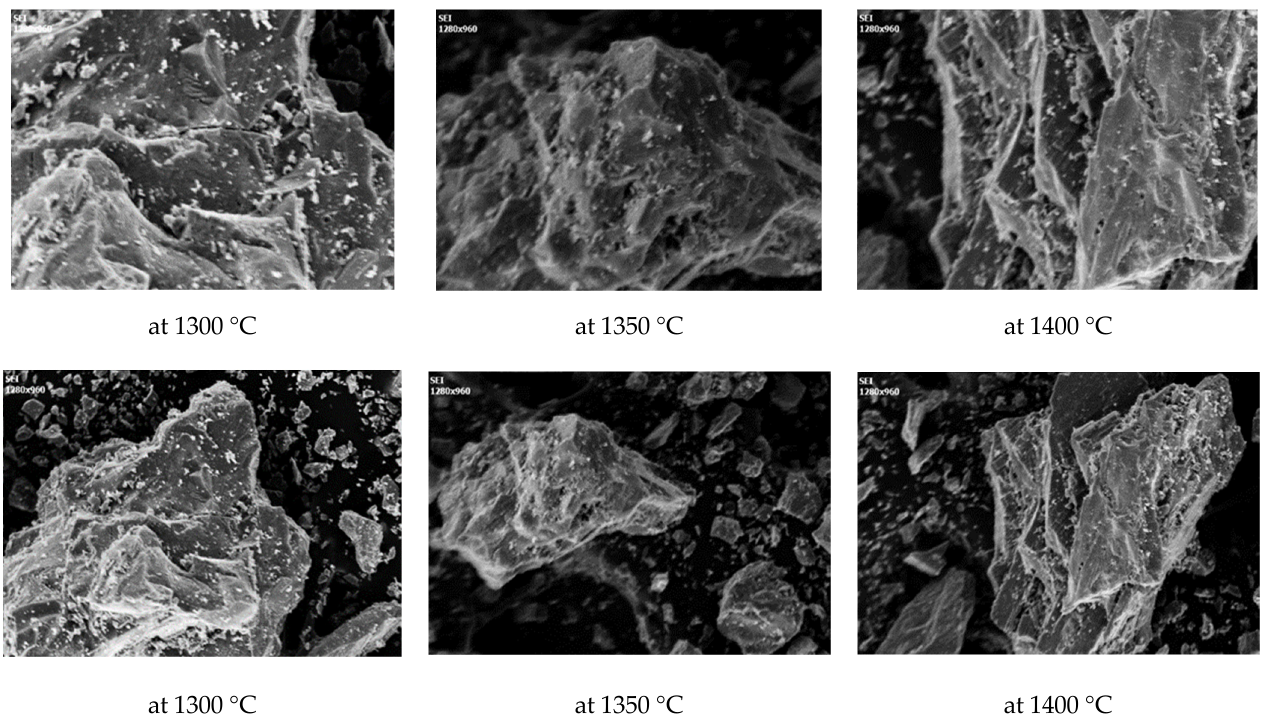
Figure 8. Pictures of Melting Slag by Scanning Electron Microscopy (the top: 1000 × /the bottom: 300 × ). Table 10. Results of GHG Emission for ASR Incineration and ASR Gasification. Unit: